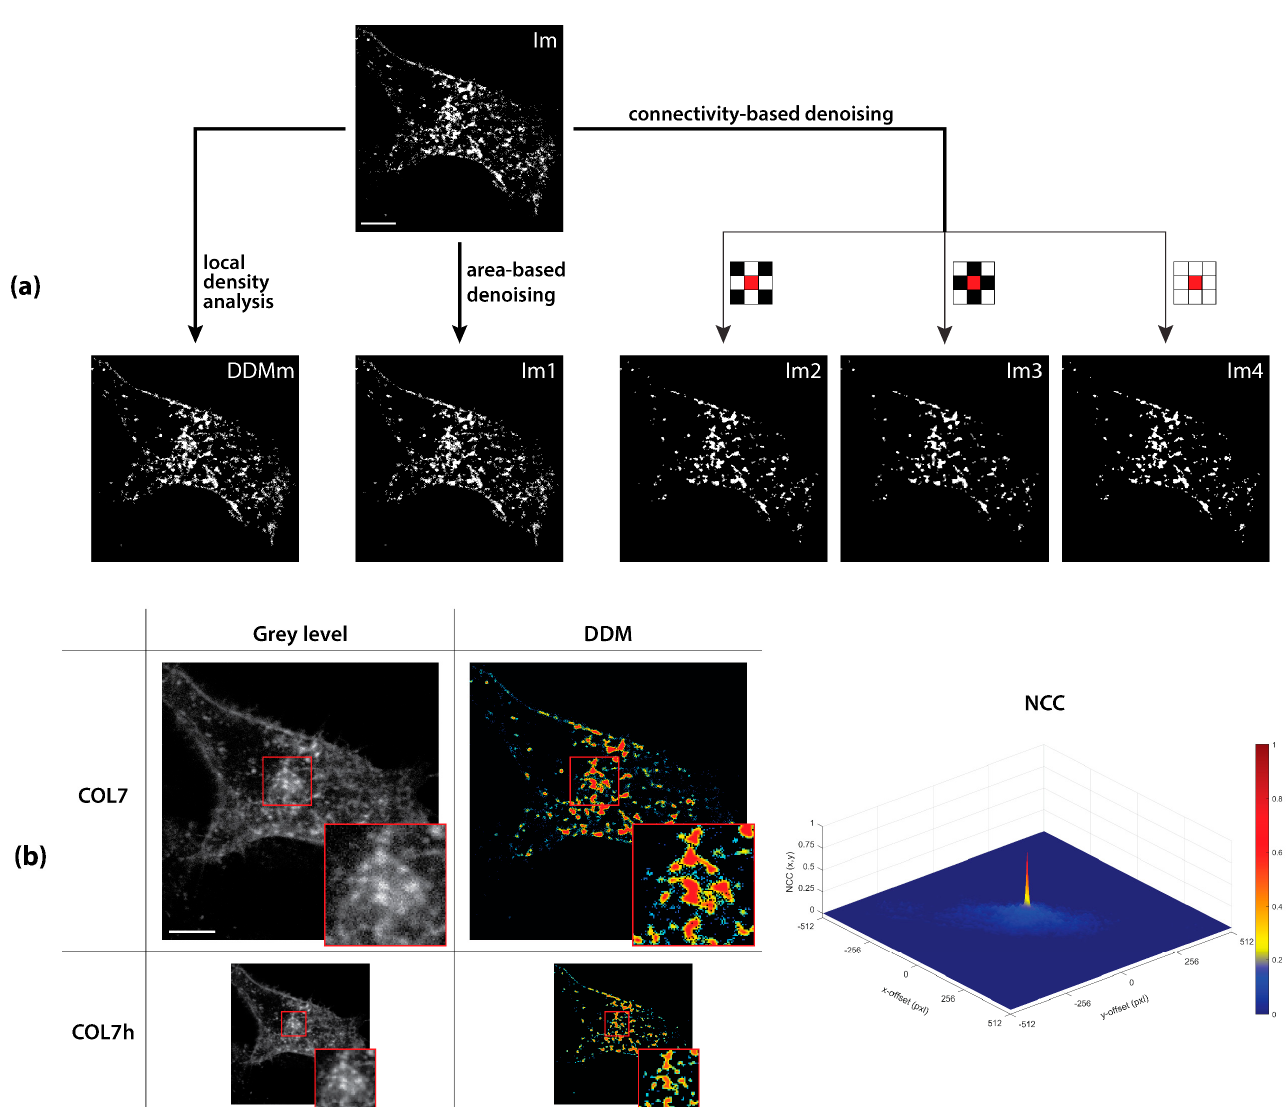
Figure 3. DDMs are effective and robust to quantify spatial distributions. ( a ) After signal binarize Table 1. removed), area- (Im1, 1-pixel object removal) or connectivity-based denoising (Im2, Im3 and Im4, 4-, diagonal- and full- connectivity-based denoising, respectively). ( b ) The signal accuracy reduction caused by resolution halving of COL7 to COL7-h is better resisted by our method application, as quantified by a maximum NCC coefficient of 0.79 for COL7 and COL7-h DDMs. The colorbar indicates the normalized function values. Scale bars: 5 µm. Table 1. Contingency table for object counting with density-, area- and connectivity-based approach.